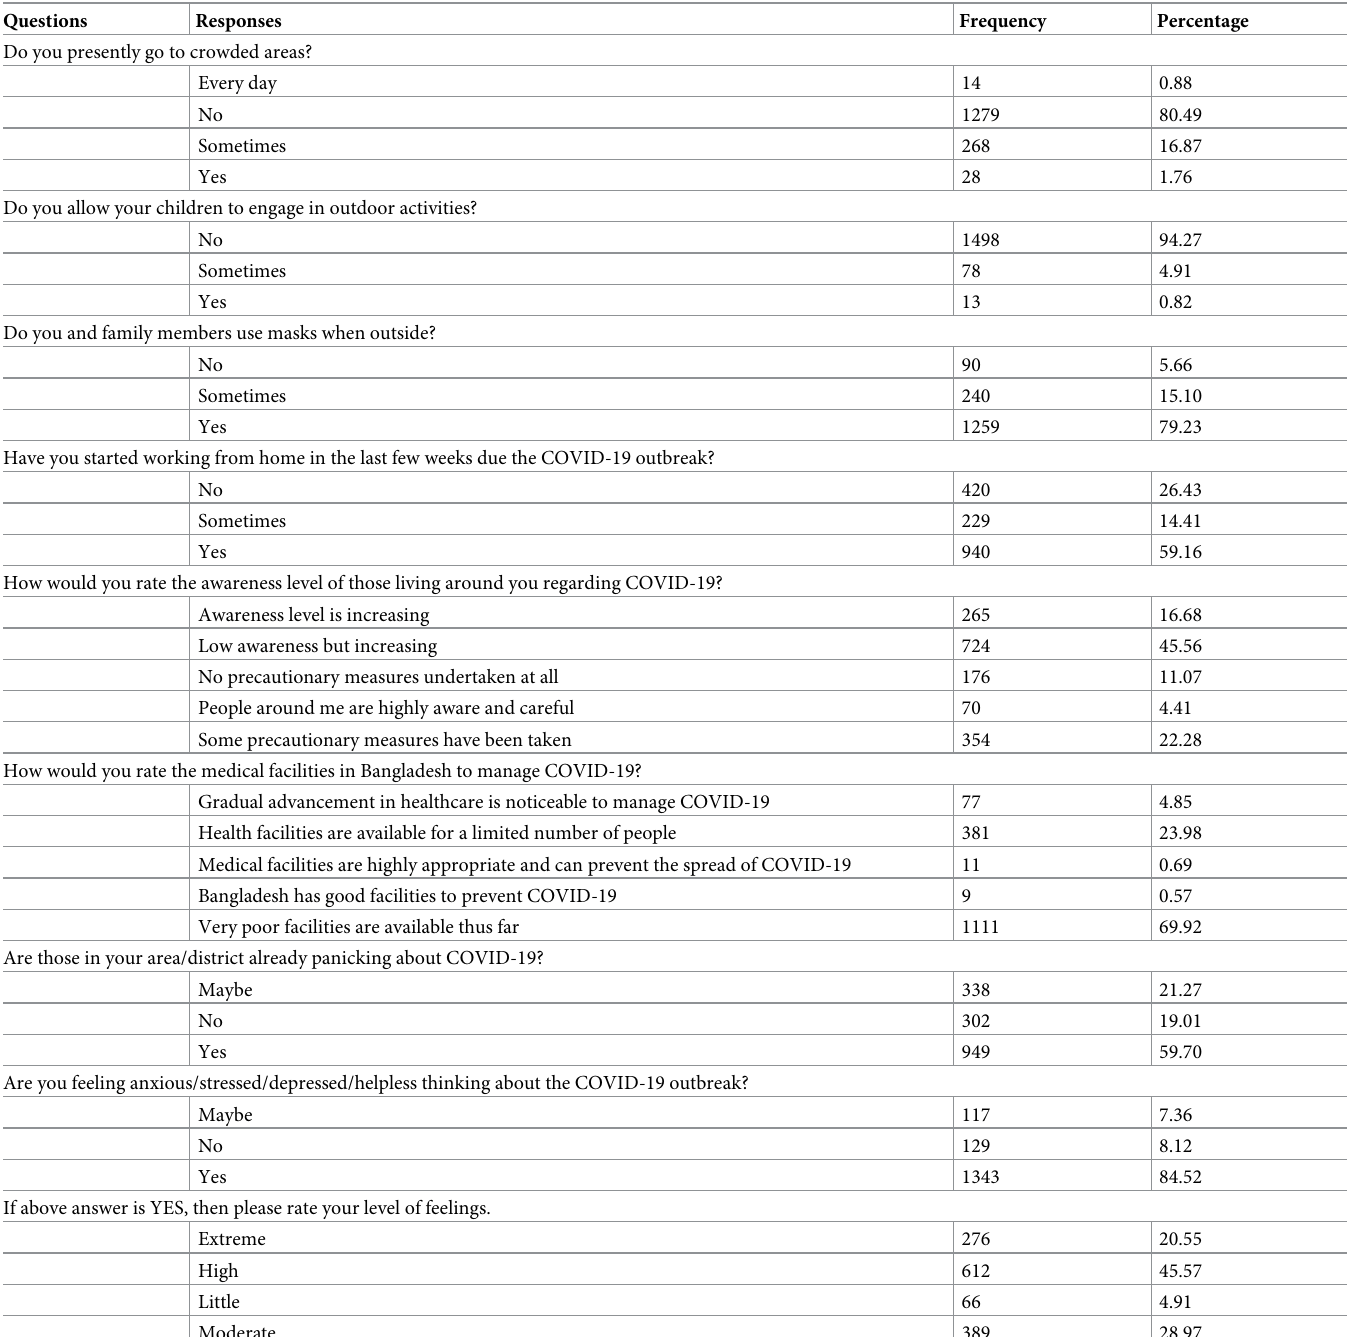
Table 5. Frequency distribution of the responses to practices